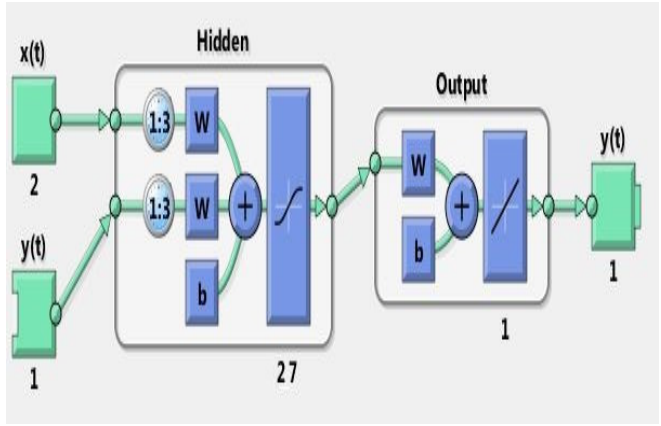
Figure 9. MATLAB implementation of MISO NARX.